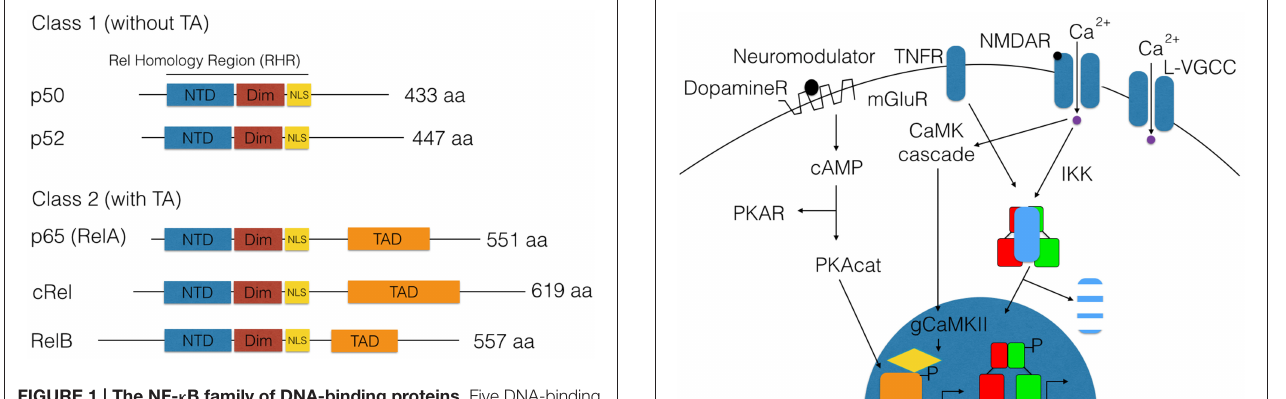
FIGURE 1 | The NF- κ B family of DNA-binding proteins. Five DNA-binding subunits found in the mammalian genome, which combine as homo- or heterodimers. A frequently found dimer is composed of p50/p65. All dimers can exist in a latent form in the cytoplasm complexed by I κ B family members. This leads to inhibition of NF- κ B due to cytoplasmic retention. Furthermore, NF- κ B subunits can be classified as Class I (without transactivation, TA) or as Class II with TA due to the presence of a transactivation domain (TAD) in the C-terminal region.